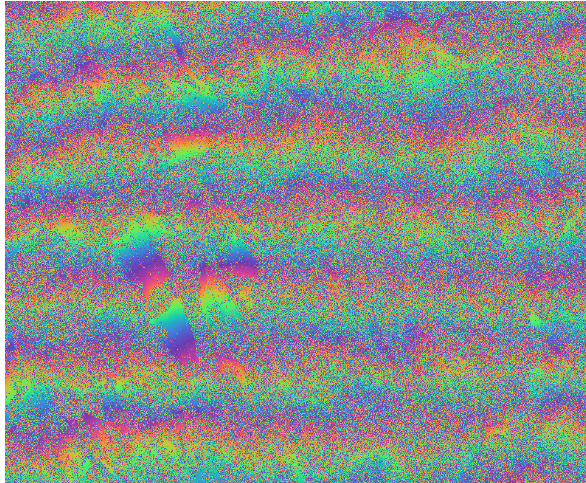
Figure 10. Interferogram of the Figure 5 after applying the Goldstein Filter